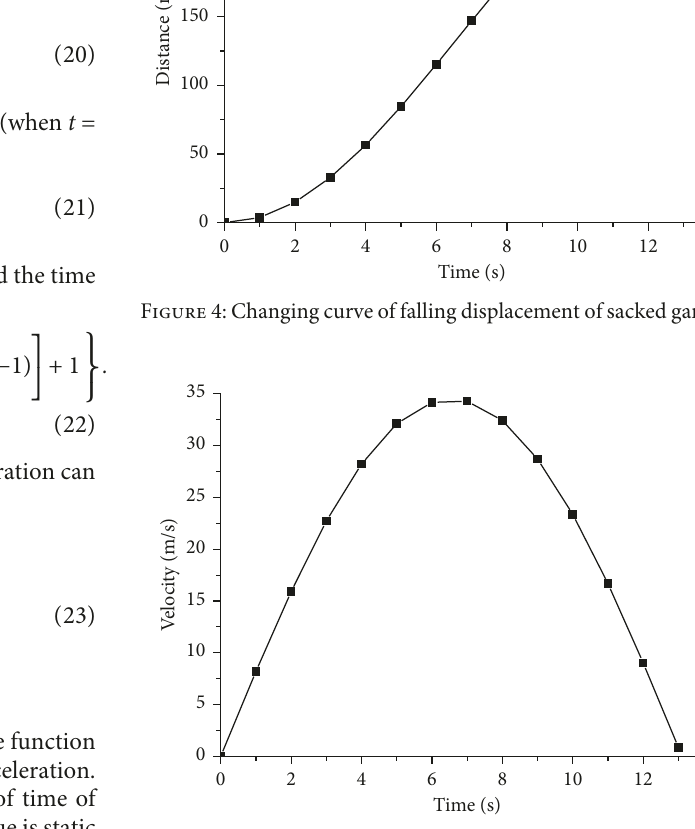
Figure 5: Changing curve of falling speed of sacked gangue.